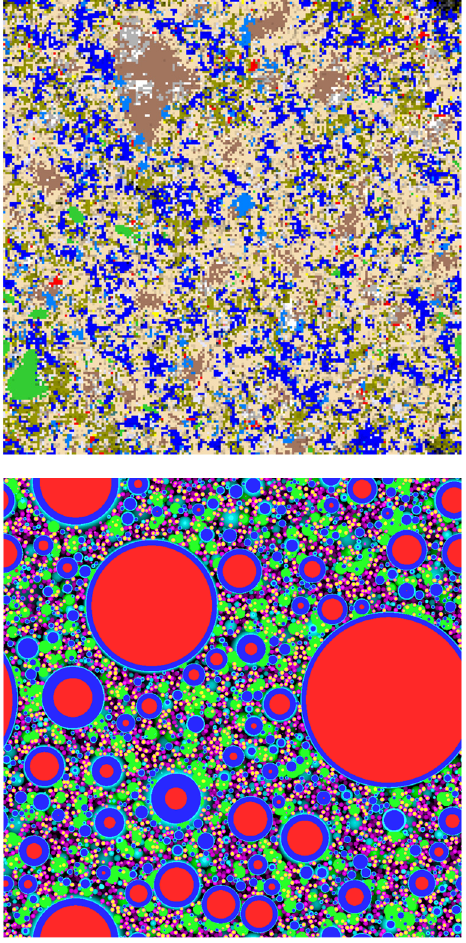
Figure 3. Slices of 100µm size from three ‐ dimensional microstructures of hydrated cement pastes simulated using CEMHYD3D showing a microstructure after 72 hours of hydration of a Portland cement with w/s = 0.45 and a 5 wt% replacement by limestone (bright green) (top) and µic showing a microstructure after 72 hours of hydration of a cement paste with w/s = 0.40 and 15% replaced by inert filler (yellow)